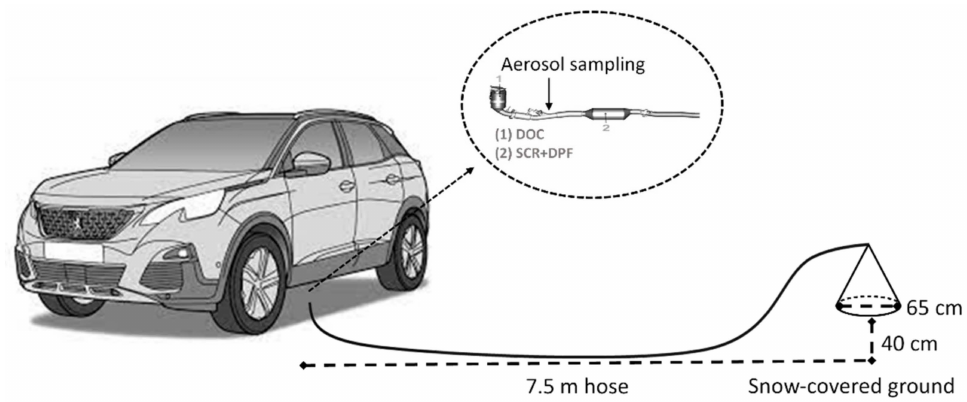
Figure 2. Scheme of the artificial contamination